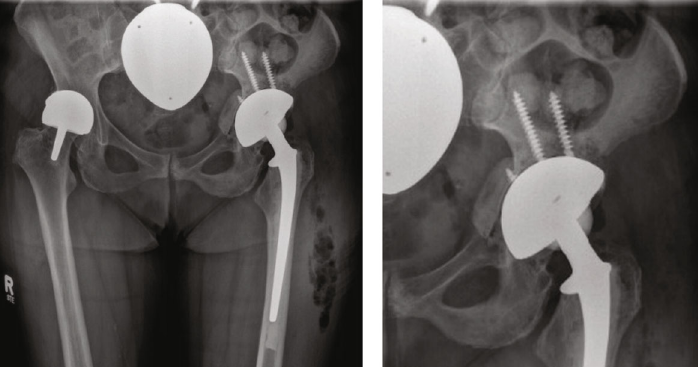
Figure 5: Surgical reconstruction after implantation of a cemented THA. (a) is an anteroposterior X-ray of the pelvis that shows the postoperative situation. On the left side, the patient carries a McMinn-like prosthesis without any symptoms or functional de fi cits. In (b), the bony acetabular reconstruction is observed. The cup was fi xated with three screws to increase rotatory stability.